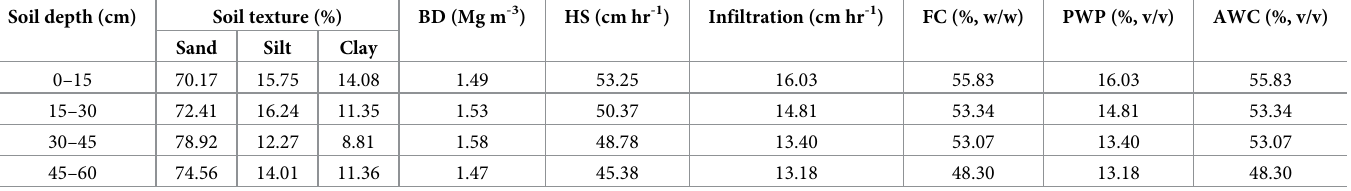
Table 1. Physical and hydro-physical properties of the experimental soil. Soil depth